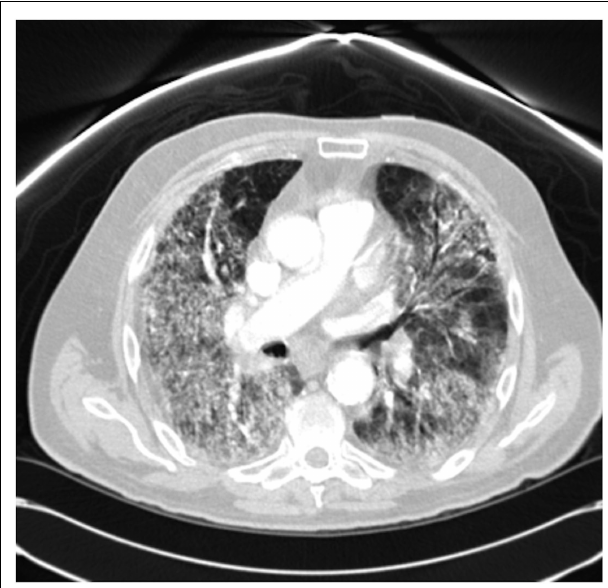
FIGURE 1 | Pneumonitis with pulmonary parenchymal abnormalities in a patient with stage IIIA NSCLC treated with dasatinib and concurrent